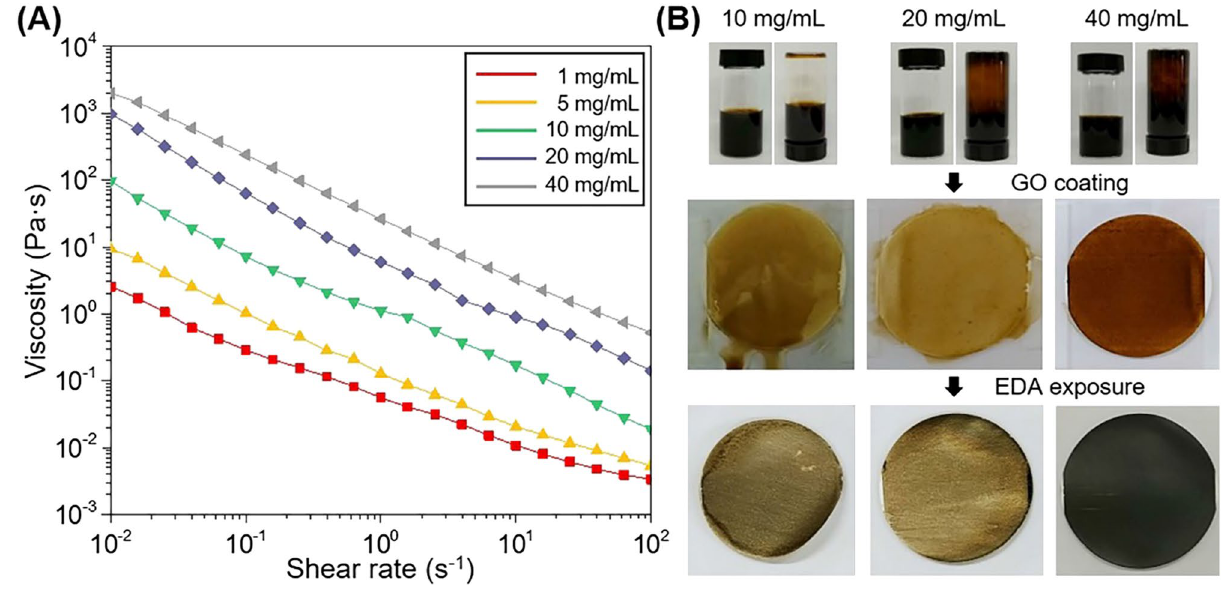
Figure 2. Viscoelastic rheological properties of the GO solution. ( A ) Viscosity of GO solution as a function of shear rate and concentration. ( B ) GO/EDA coating quality depending on the concentration of the GO solution. The EDA exposure time was 1